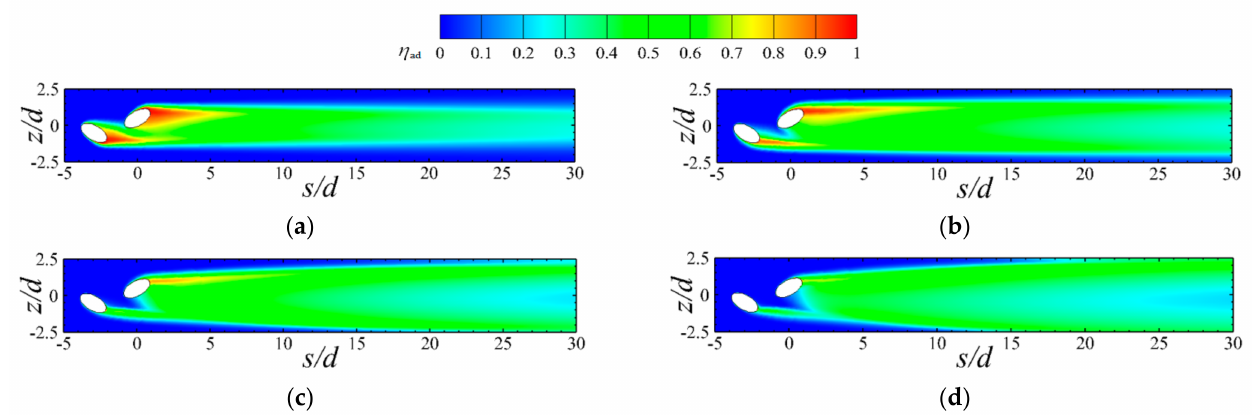
Figure 6. Local film cooling effectiveness distribution on the pressure surface for DJFC with β = 29 ◦ and Z / d = 1.0. ( a ) M = 0.5, ( b ) M = 1.0, ( c ) M = 1.5, ( d ) M = 2.0.